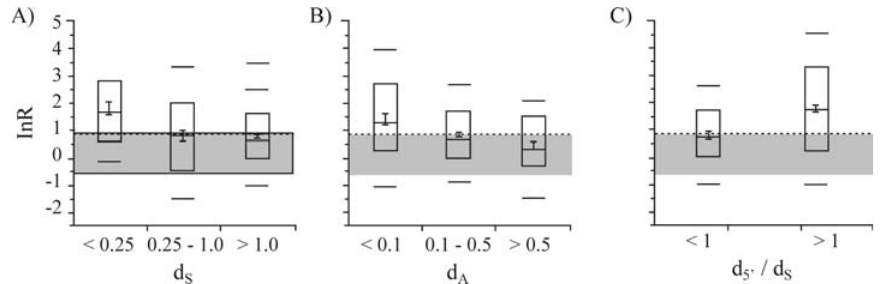
Figure 3 - The relationship between the correlation of gene expression, ln(R), between D. melanogaster duplicate gene pairs and their synonymous (A) and amino-acid site (B) divergence (d S and d A , respectively), and the evolutionary rate d 5’ /d S . Correlation of gene expression is expressed as the trans- formed Pearson’s correlation coefficient over experimental conditions (see methods). The following quantiles are shown: 90%, 75%, mean (1 SE), me- dian,25%,and10%.Onlythemeansofthetwobinsd S <0.25and0.25<d S <1differat α =0.0001(A)andd A <0.1and0.1<d A <0.5differat α =0.0001 (B)(Student’st-test).Nofurthersignificantdifferenceswerefoundbetweenanyoftheremainingbinsgiveninthemethodssection.Thegrandmeanisde- picted by the dotted line. The shaded area represents the 99% range of ln(R) values obtained from a randomized dataset (c.f. Figure S2). Table 1 - Divergence levels 1 at synonymous sites (S), in the 5 prime regions (5’), and at amino-acid replacement sites (A) sites, and the resulting rates d 5’ /d S and d A /d S .